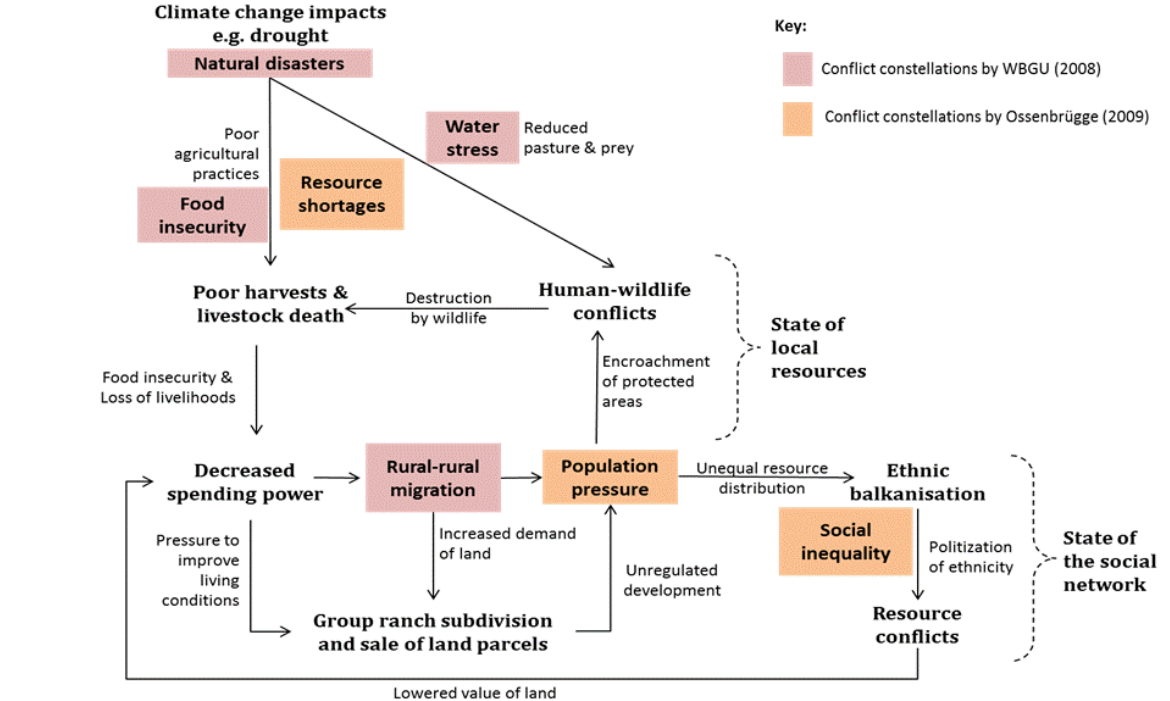
Figure 1. Conflict constellations in relation to climate change and rural land tenure. Source: the